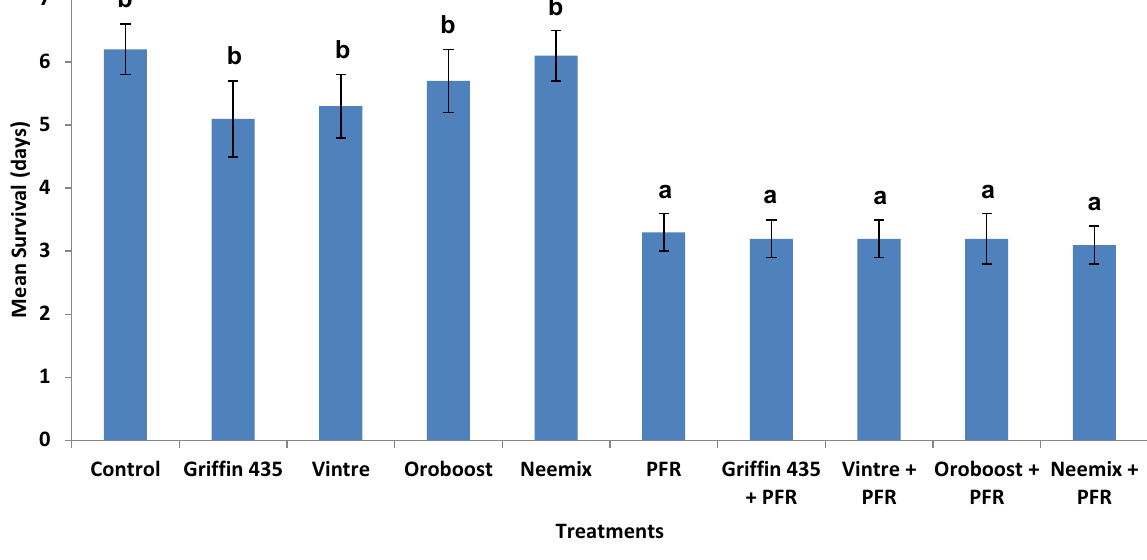
Figure 4. Effect of oils and Isaria fumosorosea (PFR) alone and in combination on psyllid survival. Data show survival (days) for D. citri exposed to oil (0.2% v/v) treated citrus leaves in the laboratory over 7 days. Data are mean ± SEM of two tests (10 replicates per test) and letters indicate significance ( P < 0.05, Duncan's multiple range